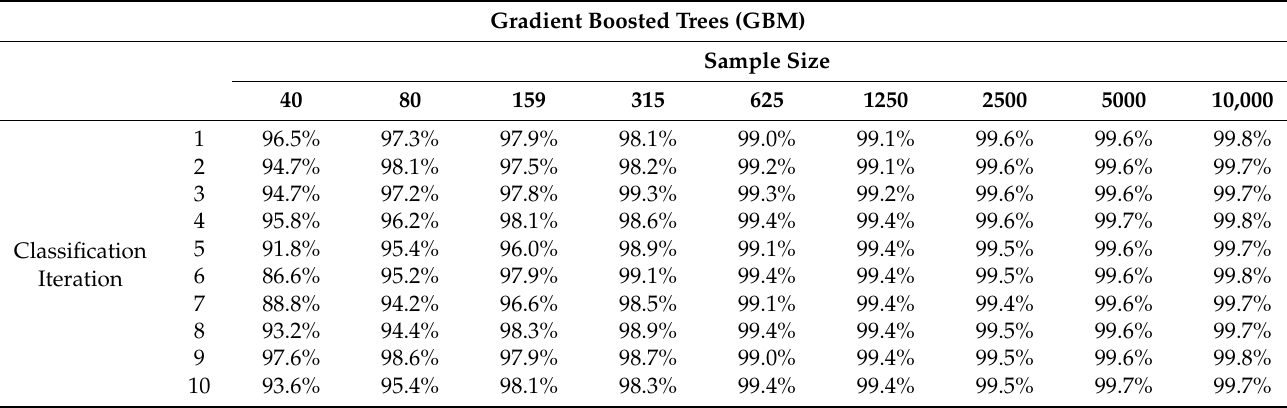
Table A6. Overall Accuracies of Gradient Boosted Trees (GBM)